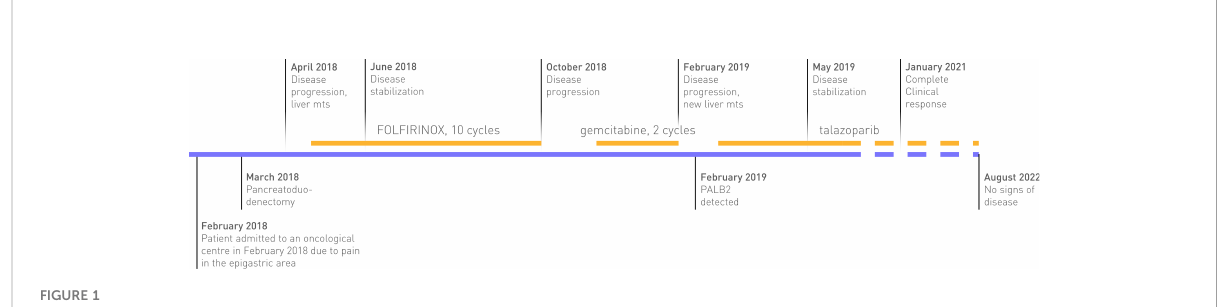
FIGURE 1 Timeline from fi rst visit to last